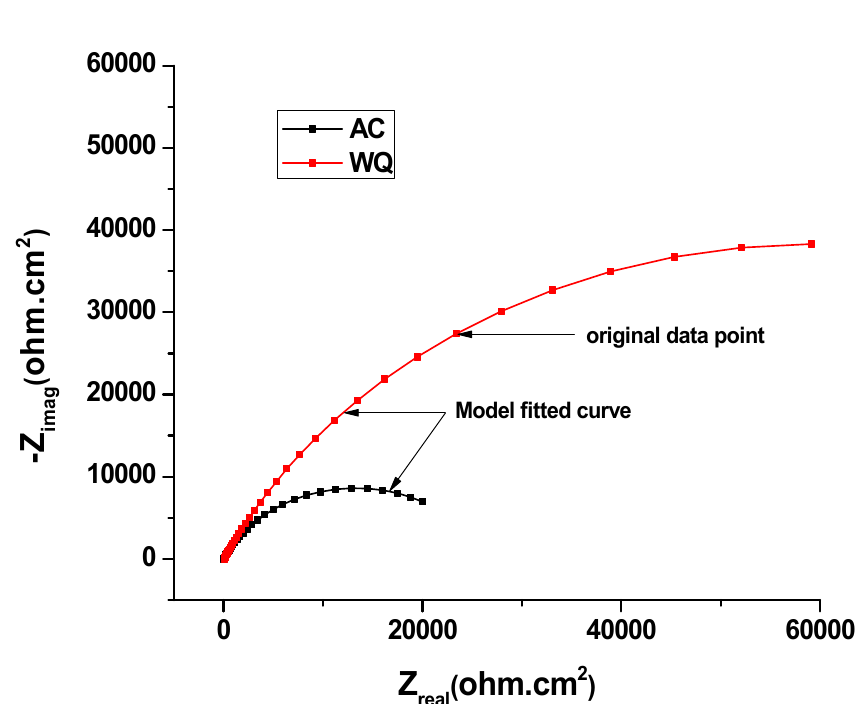
Figure 5. EIS Nyquist plot of AC and WQ Ti-6Al-4V alloy in Ringer’s solution. Table 4. EIS data of heat-treated Ti-6Al-4V alloy in Ringer’s